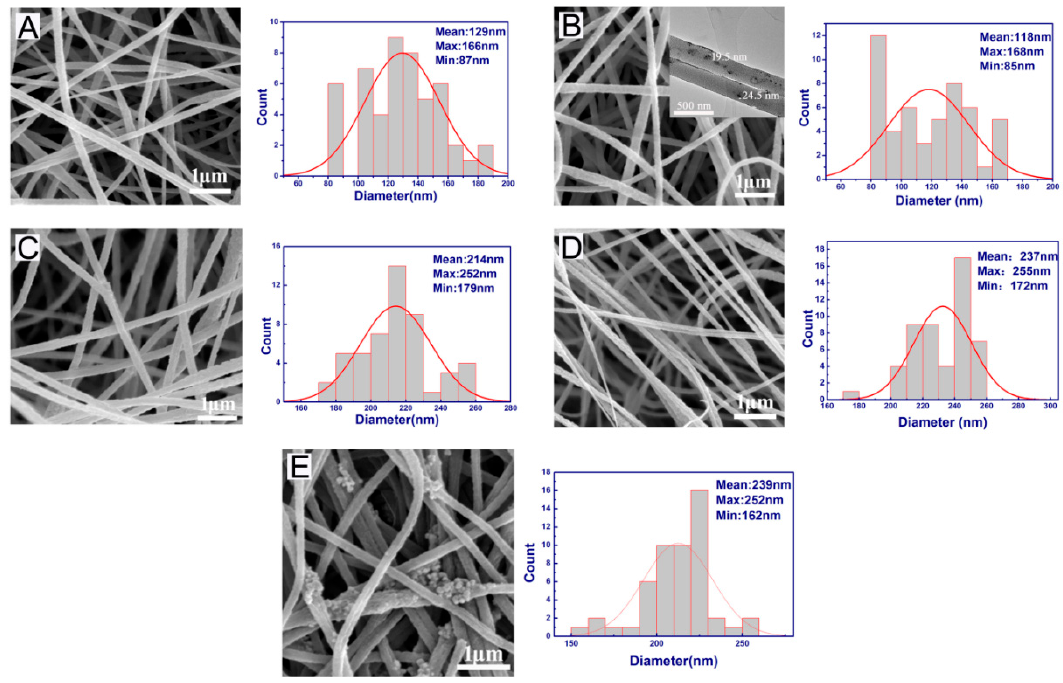
Figure 2. FE-SEM micrographs and corresponding fiber diameter distribution of electrospun nanofibers. ( A ) PAN; ( B ) PAN/Ag; ( C ) PAN/CNC/Ag; ( D ) PAN/CNC/Ag/Si; and ( E ) p-PAN/CNC/Ag. Inset in ( B ) is the TEM micrograph of PAN/Ag showing Ag particles.